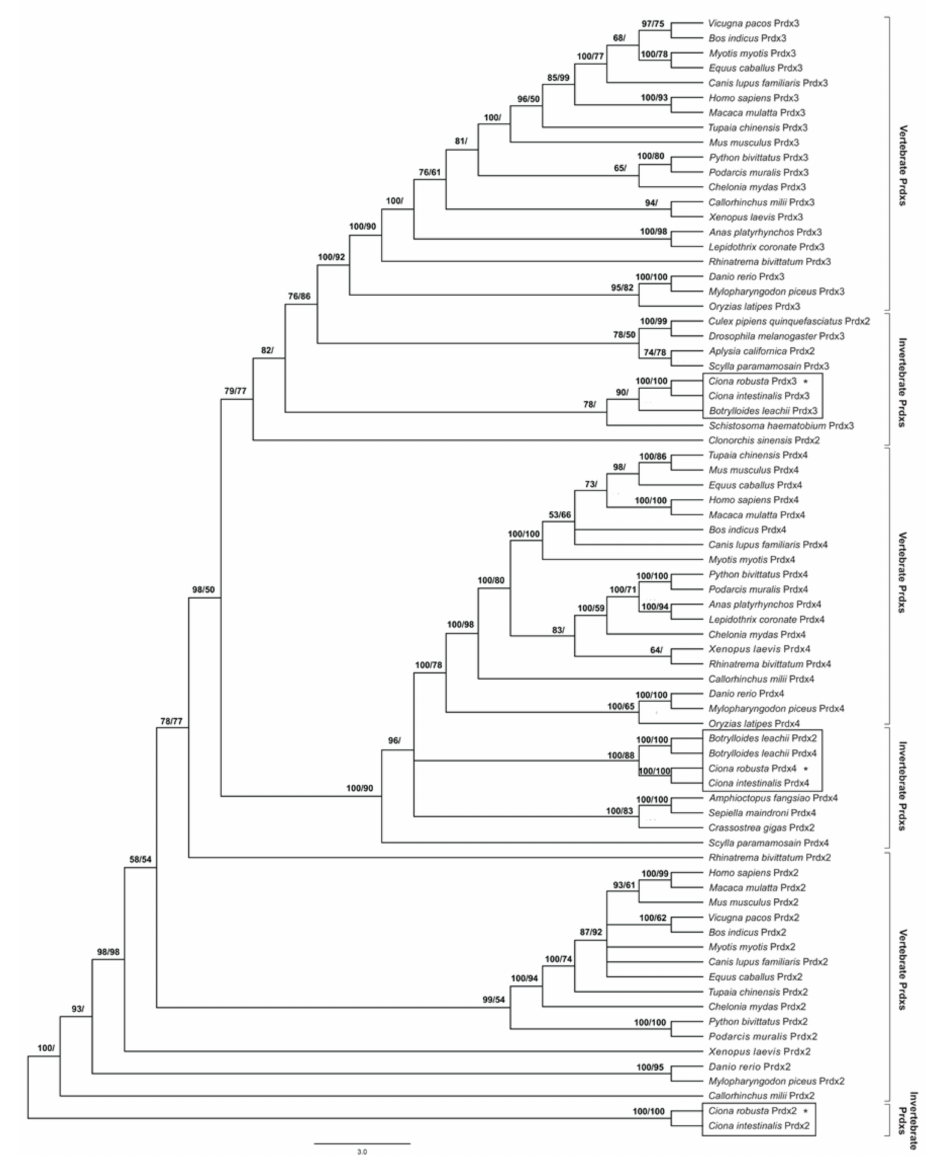
Figure 1. Phylogenetic relationships among Prdxs of various organisms reconstructed on the basis of the cDNA coding region sequences and using both Bayesian interference (BI) and maximum likelihood (ML) methods. Bayesian posterior probability (first number) and bootstrap values higher (and equal to) than 50% are indicated on each node, respectively. The scale for branch length (3.0 substitution/site) is shown below the tree. Asterisks indicate the C. robusta Prdxs. ProtTest3 statistical results determined that the WAG+G model was the best model to apply for the phylogenetic analysis of Prdx amino acid sequences, with a gamma shape value (four rate categories) of 0.444 using all statistical criteria ( − lnL = 13,169.13). Figure S7 shows a Prdx phylogenetic tree generated by applying the BI and ML methods to the data set of amino acid sequences. The cladogram topology is quite similar to the previous one, though in this cladogram, three clades are identified, each including the sequences of a specific isoform, with the same exceptions previously highlighted (in this case, Clonorchis sinensis Prdx2 emerged close to